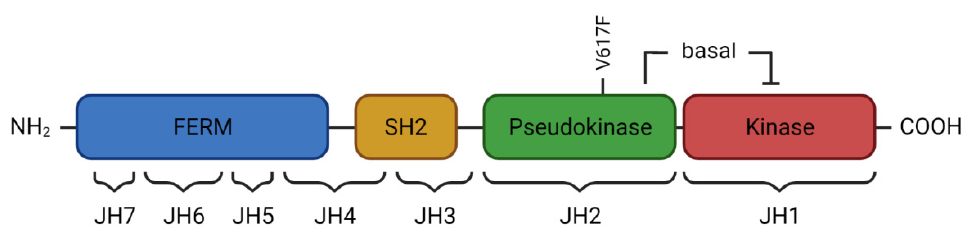
Figure 1. Schematic representation of the JAK2 domain structure. Seven Janus homology domains (JH1–JH7) constitute the N -terminal FERM and SH2 domain associating with the intracellular domains of cell surface receptors as well as the C-terminal pseudokinase and kinase domain of JAK2. The JAK2 V617F mutation locates to the pseudokinase domain, interfering with the basal inhibitory effect of the pseudokinase on the kinase domain, leading to constitutive JAK2 activation. JAK2 activation occurs upon ligand binding to hematopoietic cytokine receptors such as the erythropoietin receptor (EPOR), thrombopoietin receptor (TPOR or MPL), or the granulocyte-macrophage colony-stimulating factor (GM-CSFR), as well as IL-3 and IL-5 receptors. JAK2 is also the mediator of signaling from growth hormone, leptin, and prolactin receptors [1] (Figure 2). Receptor dimerization enables transphosphorylation of the tandem tyrosines Y1007 and Y1008 in the activation loop of the JAK2 kinase domain, increasing catalytic activity [12].